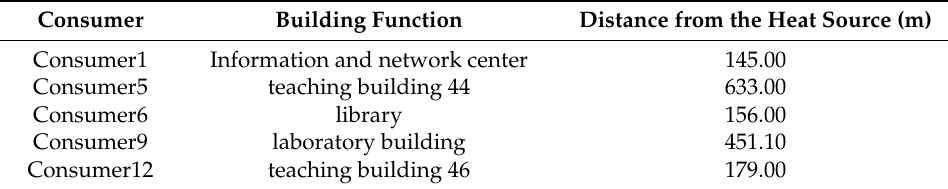
Table 1. Building function and distance from the heat source about each consumer.